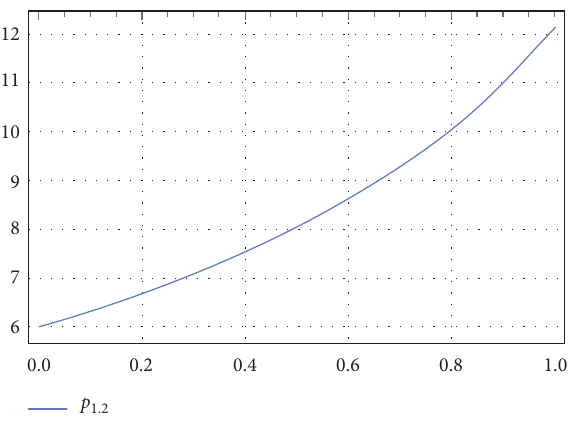
Figure 2: Product prices under b changing.